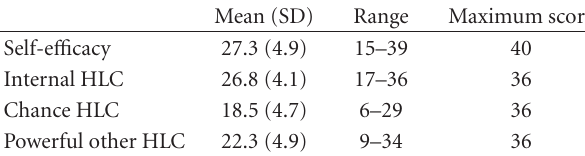
Table 1: Participants’ demographics and step count ( n = 105).